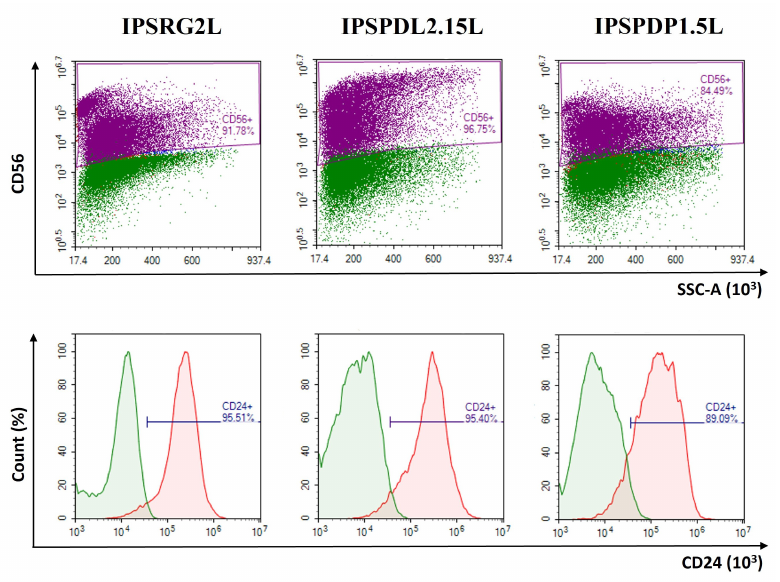
Figure 4. Results of flow cytometry analysis of neurons differentiated from iPSCs obtained from the material of patients with PD and from a healthy donor, on differentiation day 65. Up- per panel—CD56 (N-CAM)—neural cell adhesion molecule, bottom panel—CD24—cell adhesion molecule. IPSRG2L—iPSC line from healthy donor; IPSPDL2.15L—iPSC line from PD patient with mutation in PARK8 gene, IPSPDP1.5L—iPSC line from PD patient with mutation in PARK2 gene. The data are presented as an overlay image of plots for specific antibody-stained cells and isotype- control antibody-stained cells. Green—isotype control, violet—cells stained for N-CAM, red—cells stained for